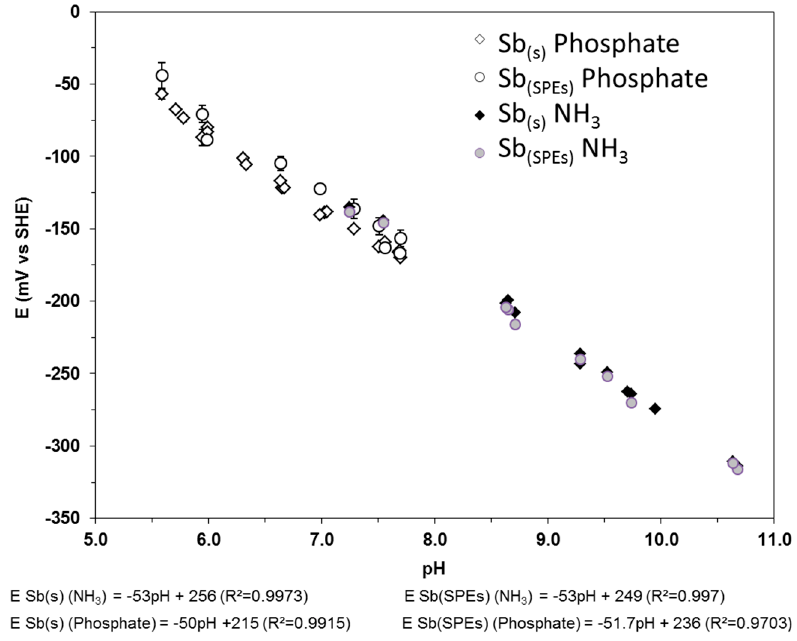
Figure 6. Eh-pH diagram of both the Sb(s) and Sb(SPEs) acquired at 25 °C, at atmospheric pressure, in phosphate and ammonia pH buffer solutions (IS = 0.1).